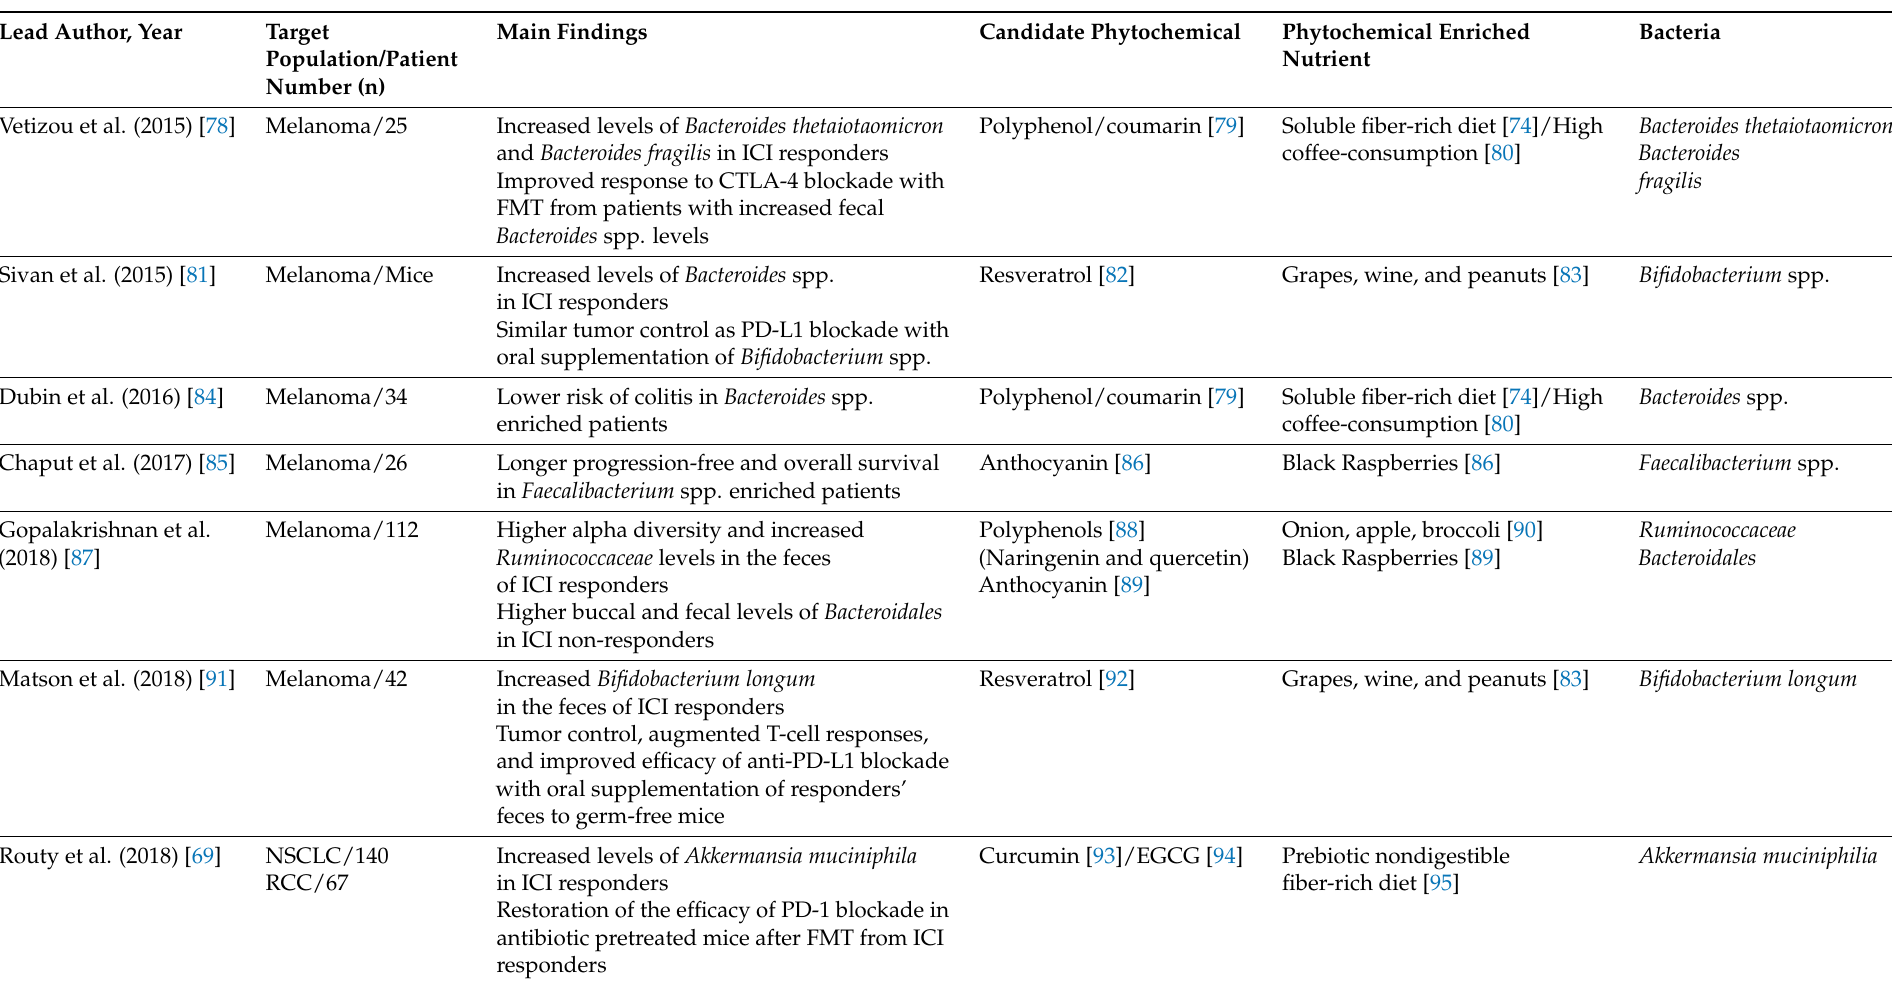
Table 3. Summary of phytochemicals as modifiers of the gut microbiome in the immunotherapy studies (adapted from Guven DC et al.